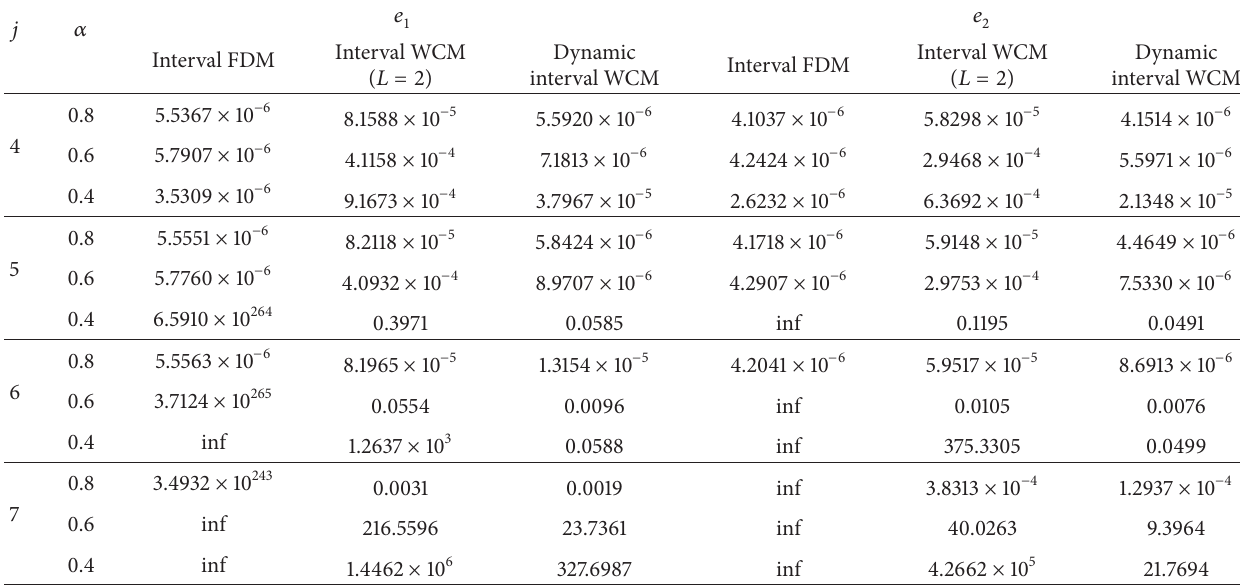
Table 2: Influence of 𝛼 on the numerical precision ( 𝑡 = 0.0001 , 𝑇 = 0.1 ).